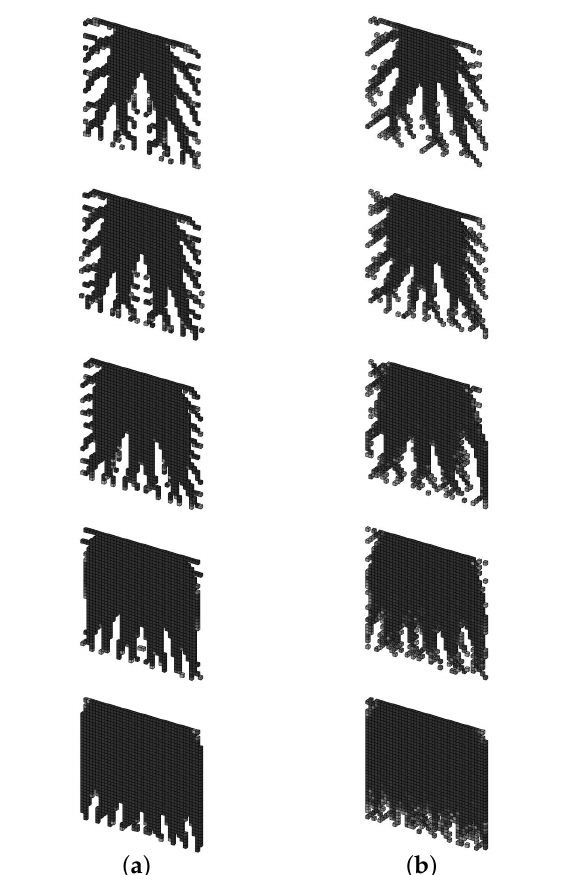
Figure 11. The results for optimized topology of heat conduction in different volume fractions of 0.5, 0.6, 0.7, 0.8, and 0.9.( a ) Results from the literature. ( b ) Results from the proposed